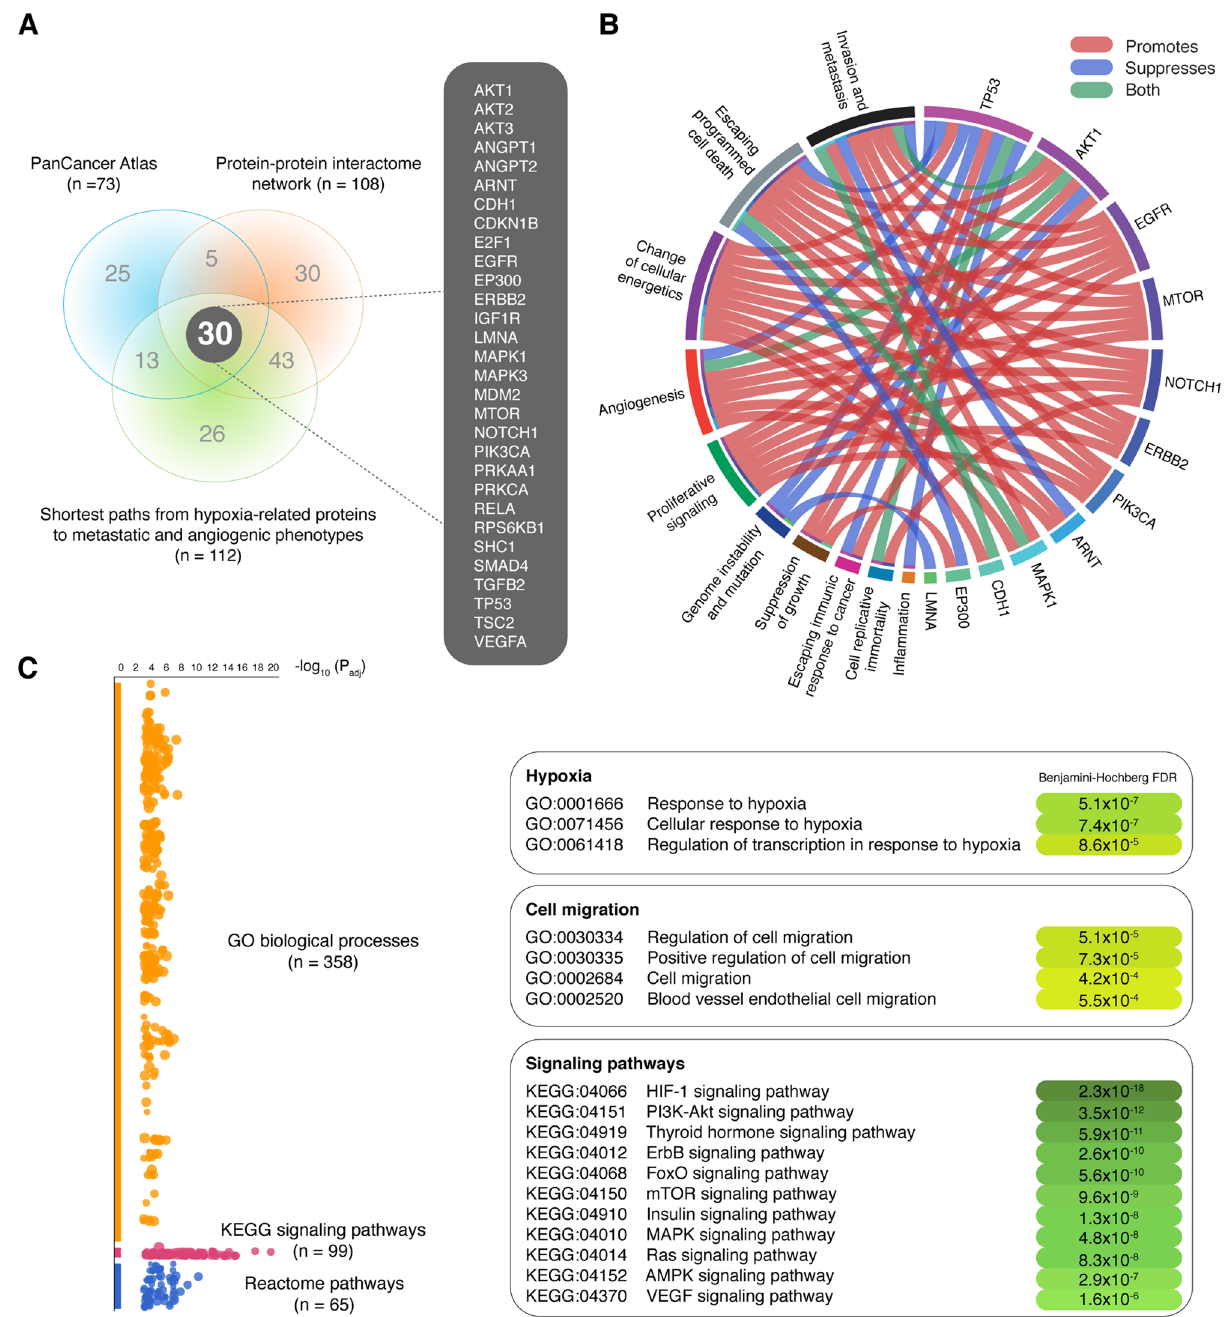
Figure 7. Integration of multi-omics approaches and functional enrichment analysis. ( A ) Venn diagram shows 30 hypoxic/metastatic/angiogenic proteins significantly expressed in the PCA-TCGA, the protein–protein interactome network, and the shortest paths to cancer hallmark phenotypes (metastasis and angiogenesis). ( B ) Circos plot showing that several hypoxia-related proteins promote or suppress cancer hallmark phenotypes. ( C ) Manhattan plot of the functional enrichment analysis showing the most significant GO: biological processes related to hypoxia and cell migration, and the most significant signaling pathways with a Benjamini–Hochberg FDR q < 0.001. FDR: false discovery rate; GO: gene ontology; KEGG: Kyoto Encyclopedia of Genes and